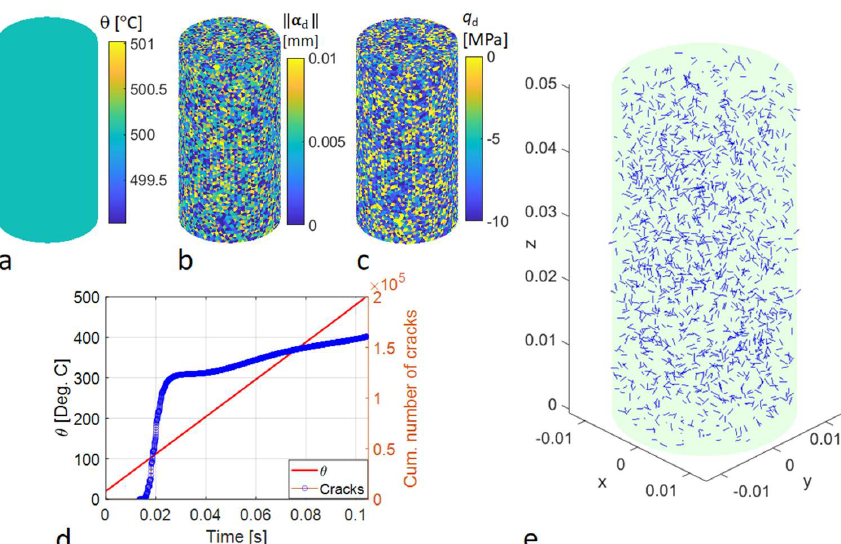
Figure 4. Simulation results for heat treatment (500 ◦ C, NumRock1): ( a ) Temperature field; ( b ) Crack opening magnitude; ( c ) Stress-like softening variable; ( d ) Temperature and cumulative crack number evolution in time; ( e ) Thermally induced crack normal (every 100th plotted).